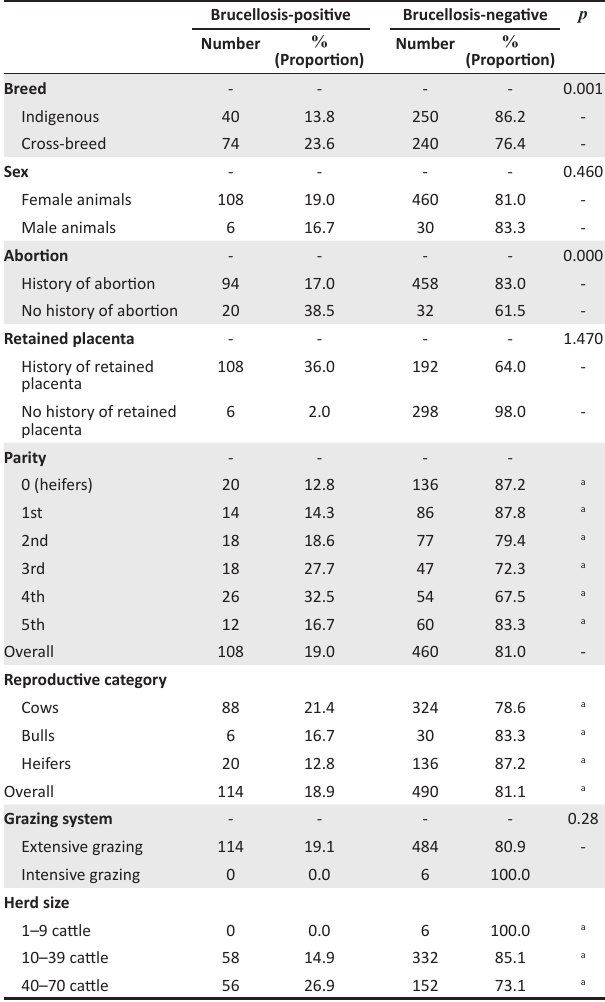
TABLE 3: Prevalence of brucellosis according to animal-related risk factors. Brucellosis-positive